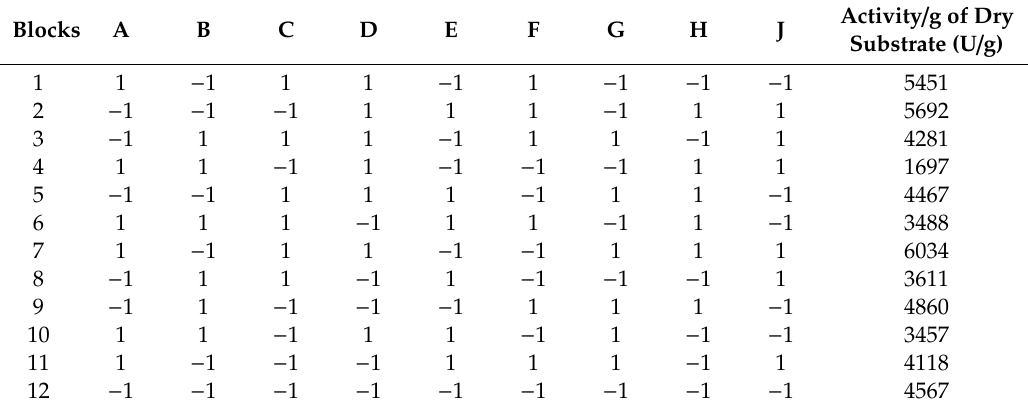
Table 5. Experimental design for the screening of nutrients using Plackett–Burman method. Blocks